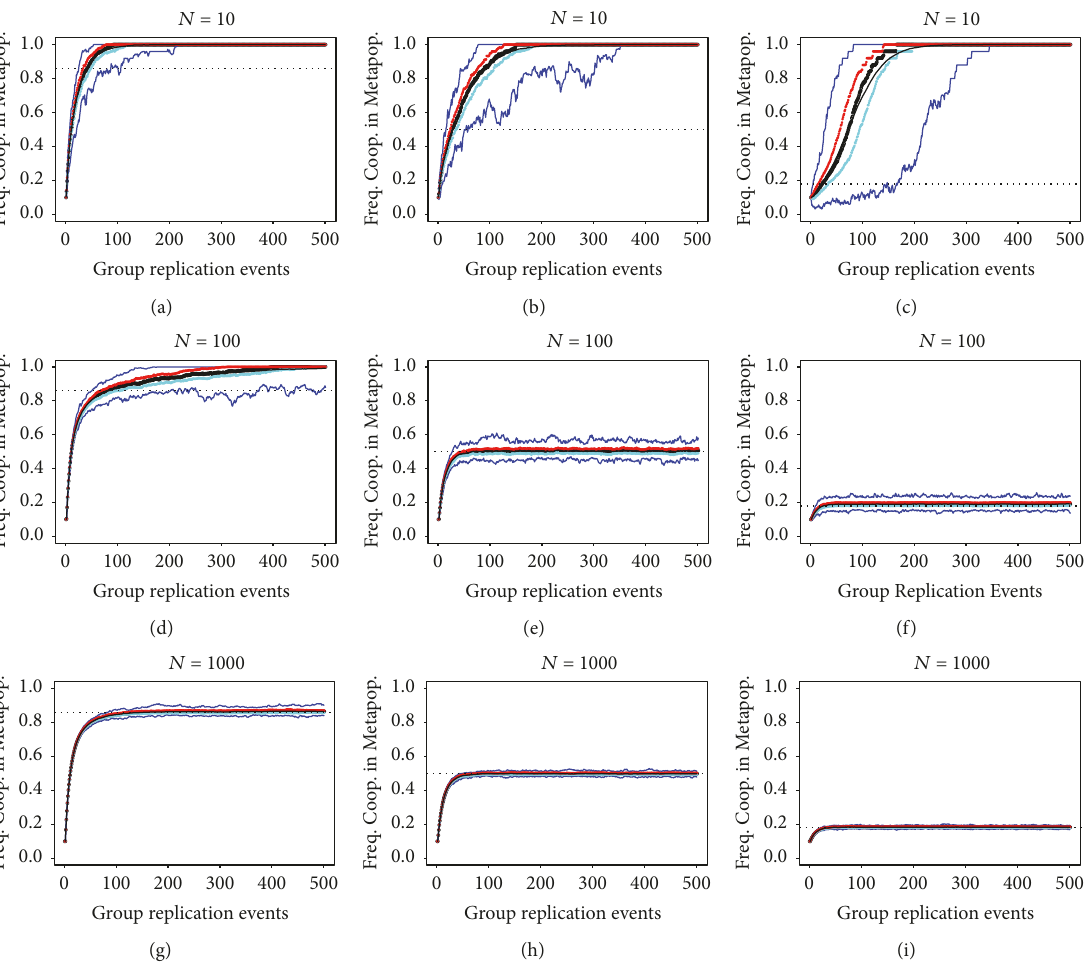
Figure 6: Two-level Moran model with no variation in r-values . Each panel represents simulation results for our metapopulation model. Panels (a, d, g) show the results for 𝑟 = .25 ; panels (b, e, h) show 𝑟 = .67 ; panels (c, f, i) show 𝑟 = .9 . Each panel shows results for 100 independent simulations with populations of 10 (a, b, c), 100 (d, e, f), and 1000 (g, h, i). In each simulation, there were 25 groups with an initial cooperator frequency of .10, 500 group replication events, and 100 within-group generations. The red, black, and light blue (cyan) dots are the first, second, and third quartiles of the observed frequencies of cooperators in the metapopulation, while the thin black line is the mean frequency. The blue lines are the maximum and minimum observed frequency across 100 simulations. The dashed, horizontal line is the long-term, expected frequency of cooperation in the metapopulation assuming a null model given by (13). Note that the observed frequency of cooperators is substantially above its value predicted by the null models for smaller populations (a)–(c) and for one larger population with a high quasi-equilibrium value